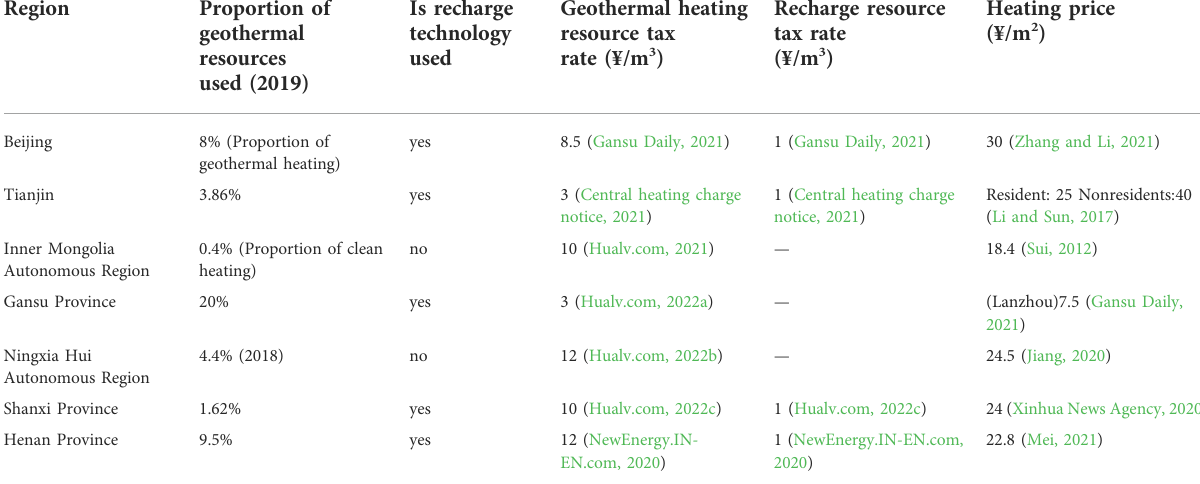
TABLE 2 Relevant input data in central heating areas. Region